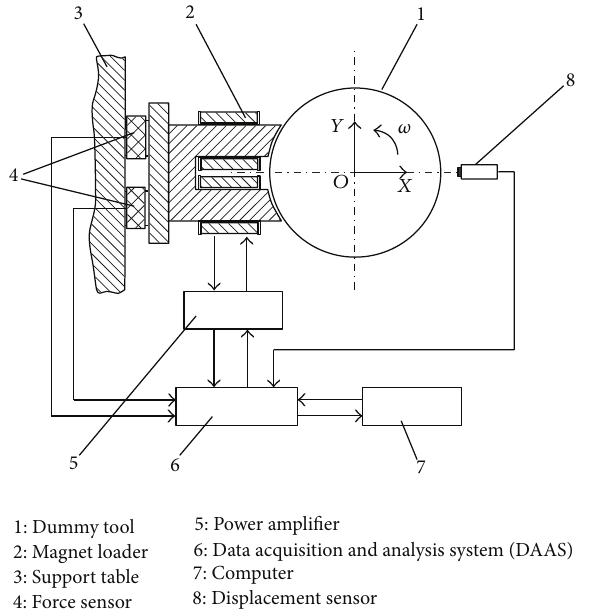
Figure 2: Structure diagram of loading and measurement device.